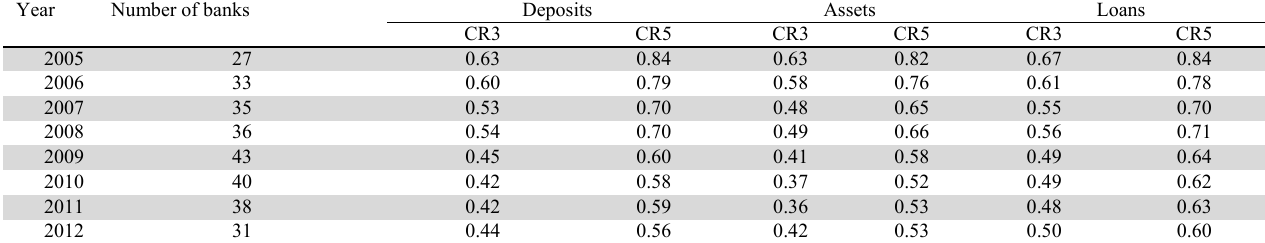
Concentration (CR3, CR5) of Vietnamese banking sector, 2005-2012